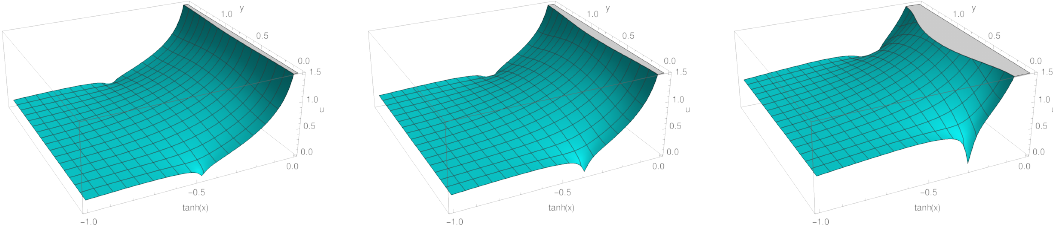
Figure 10 . Island surfaces in gravitating bath solutions, from left to right for δ ∈ { 0 . 5 , 0 . 4 , 0 . 3 } . The vertical axis shows the tortoise AdS 4 radial coordinate u . The surfaces are anchored at the conformal boundary of AdS 4 ( u → ∞ ) on the curve x ( y ) = 0 in Σ . The plots only cover the x ≤ 0 part of Σ . Near the 5-brane sources the surface caps off close to the horizon. The cap-off point at x = −∞ increases as δ